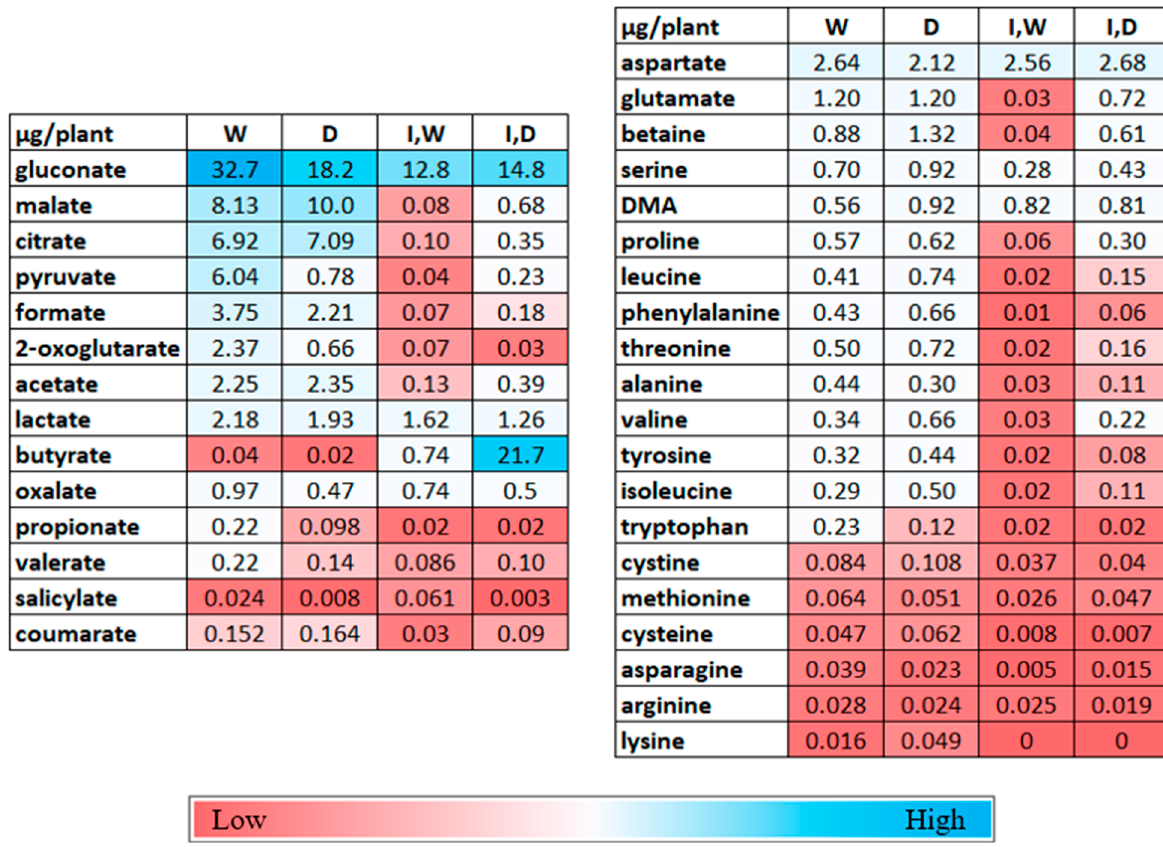
Figure 4. Representation of changes in metabolites in rhizosphere solutions after wheat seedling growth under four conditions: non-inoculated and watered (W), non-inoculated and drought-stressed (D), inoculated with Pc O6 (I) with watered growth (I,W), and inoculated with Pc O6 and drought-stressed (I,D). The values are mass µg/ plant based on nine boxes for each treatment with statistical analysis as described in Supplementary Table S4.